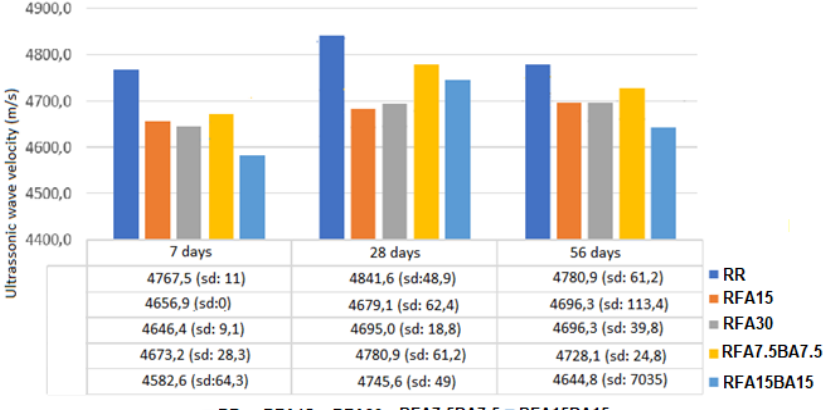
Figure 6 – Ultrasonic pulse velocity test